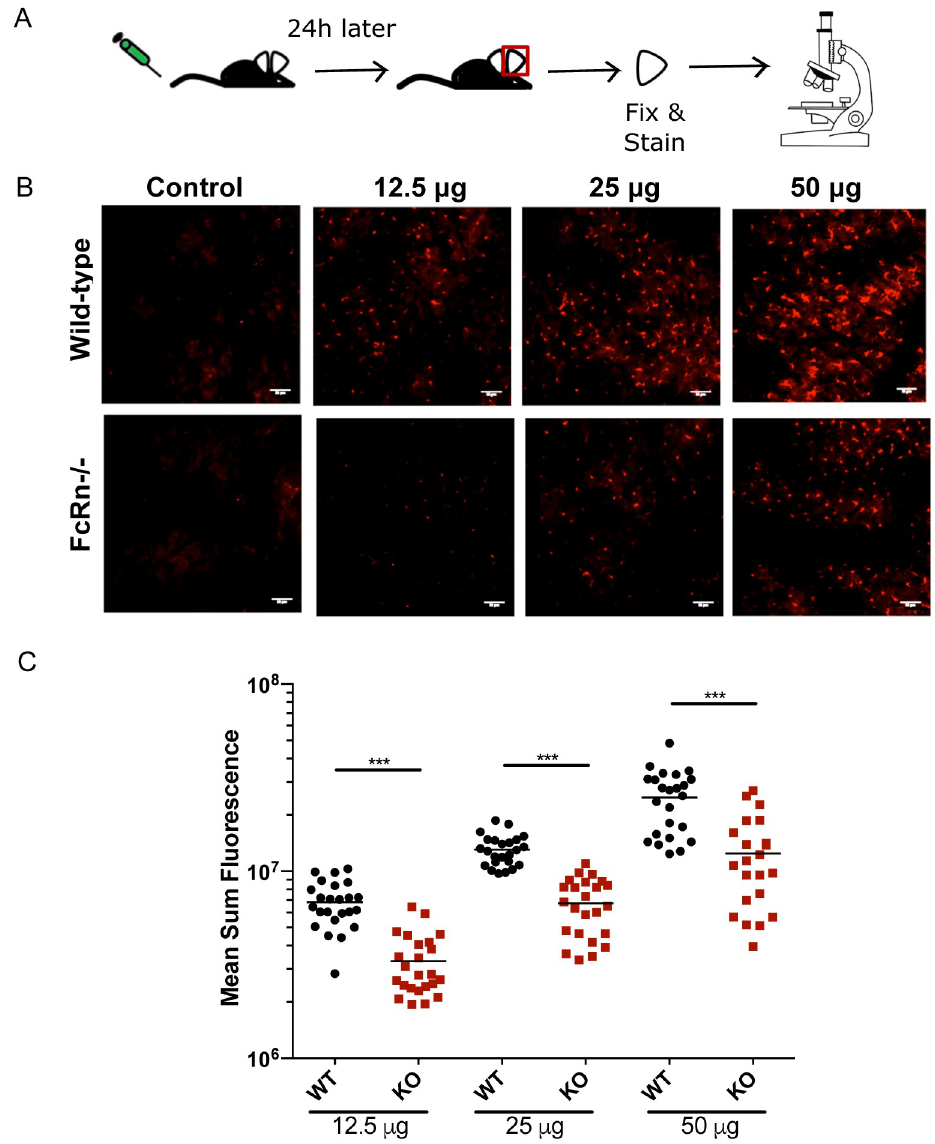
Fig 1. Concentration-dependent labeling of Langerhans cells in FcRn -/- and wild-type mice. (A) . Schematic of the experimental workflow: Wild-type and FcRn -/- mice were inoculated IV with the indicated concentrations of an anti- Langerin mAb. Twenty-four hours later, mouse ears were excised, fixed, and stained with a secondary antibody. Controls were not inoculated with anti-Langerin mAb prior to ear removal but were stained with secondary antibody. Ears were imaged by confocal microscopy. (B) Representative maximum projection images of Langerhans cell staining in ears of mice IV inoculated with anti-Langerin mAb and control ears (scale bar = 35 μ m). (C) Dot plot showing the mean sum fluorescence of labeled Langerhans cells in each image, with the line representing the mean. Data from two independent experiments were pooled. Statistical comparisons were performed using two-tailed Mann-Whitney tests (p < 0.001). The sum fluorescence was calculated using relative fluorescence units (RFU), with each spot representing the mean sum fluorescence in one image. Identical exposure times were used for all images. type controls (Fig 1C; p < 0.001), suggesting that FcRn does contribute to antibody transport in this location but is clearly not the only mechanism responsible for this process. Impor- tantly, there were no fluorescent cells in the control ears (no antibody) from either wild-type or FcRn -/- mice.